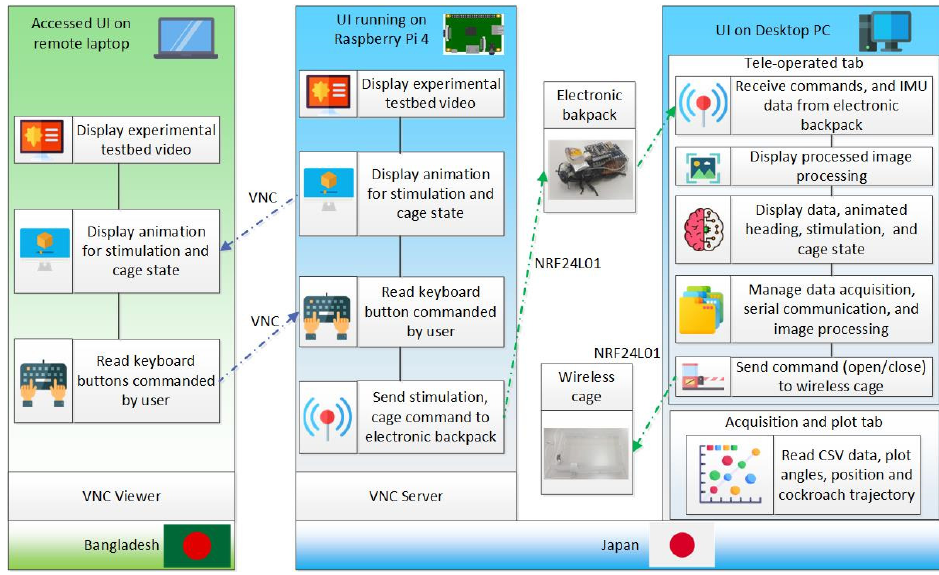
Figure 4. Overall software layout.